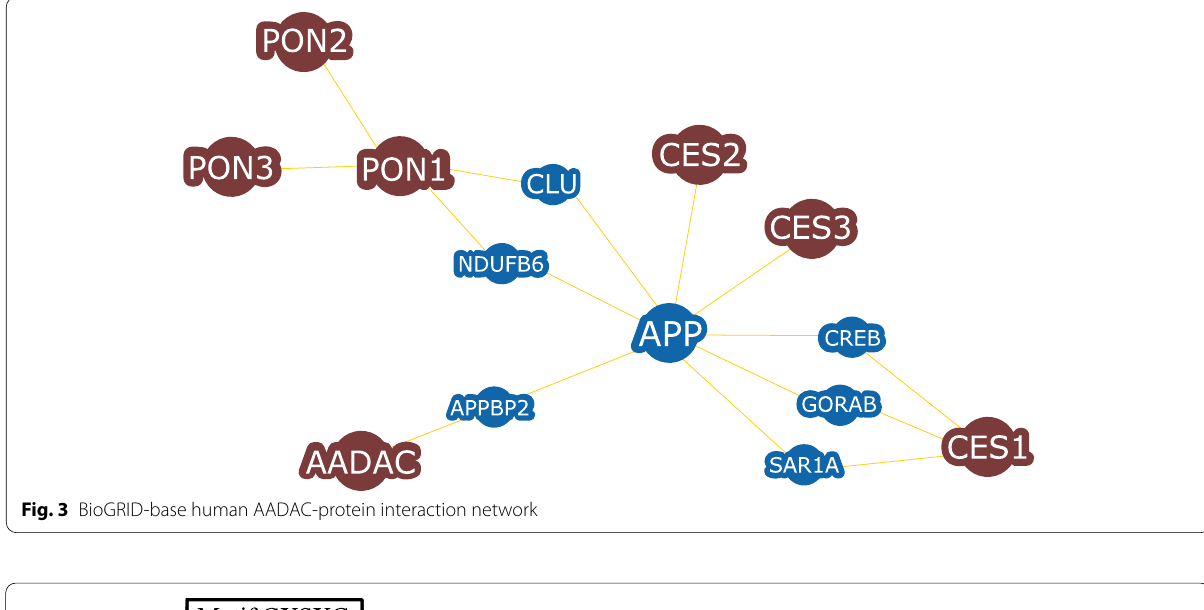
Fig. 3 BioGRID‑base human AADAC‑protein interaction network